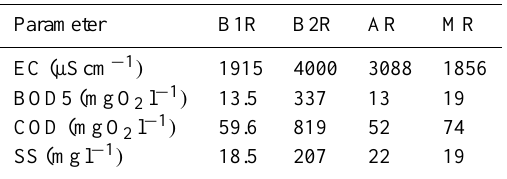
Table 2. Mean values of main properties of irrigation wastewaters used in the